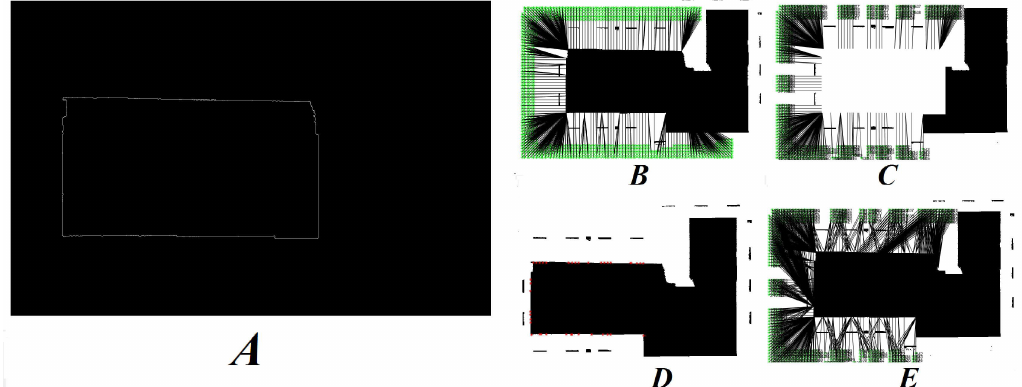
Figure 7. The points on the façade of the refectory building extracted using the edge detection algorithm ( A ); the direction of viewpoints towards the façade points without considering the obstacles ( B ); the direction of viewpoints towards the façade with considering the obstacles ( C ); the invisible points on the façade obstacles were eliminated similarly to the technique used in Figure 7C. The viewpoint orientation located in front of obstacles ( D ); the direction of viewpoints towards the faced points modified in order to see invisible points ( E